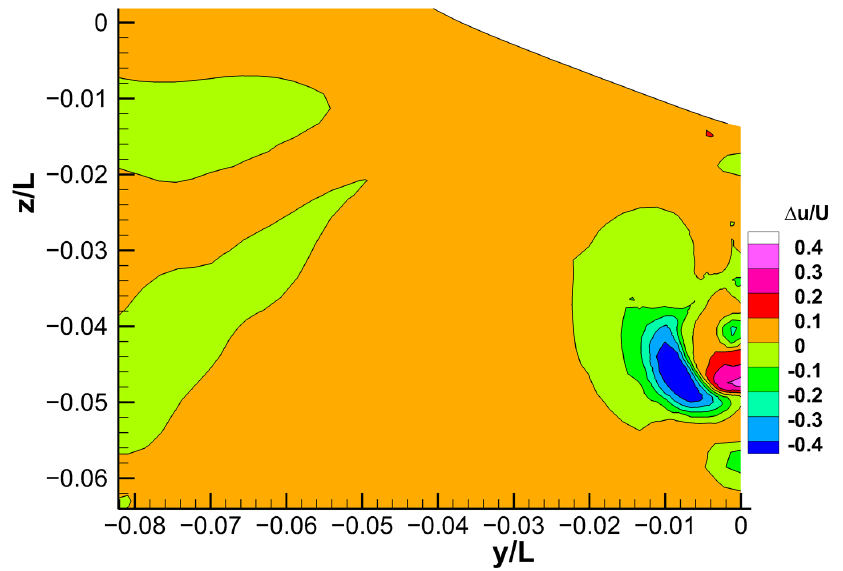
Figure 12. The difference between nominal wake velocity with and without duct for medium grid.